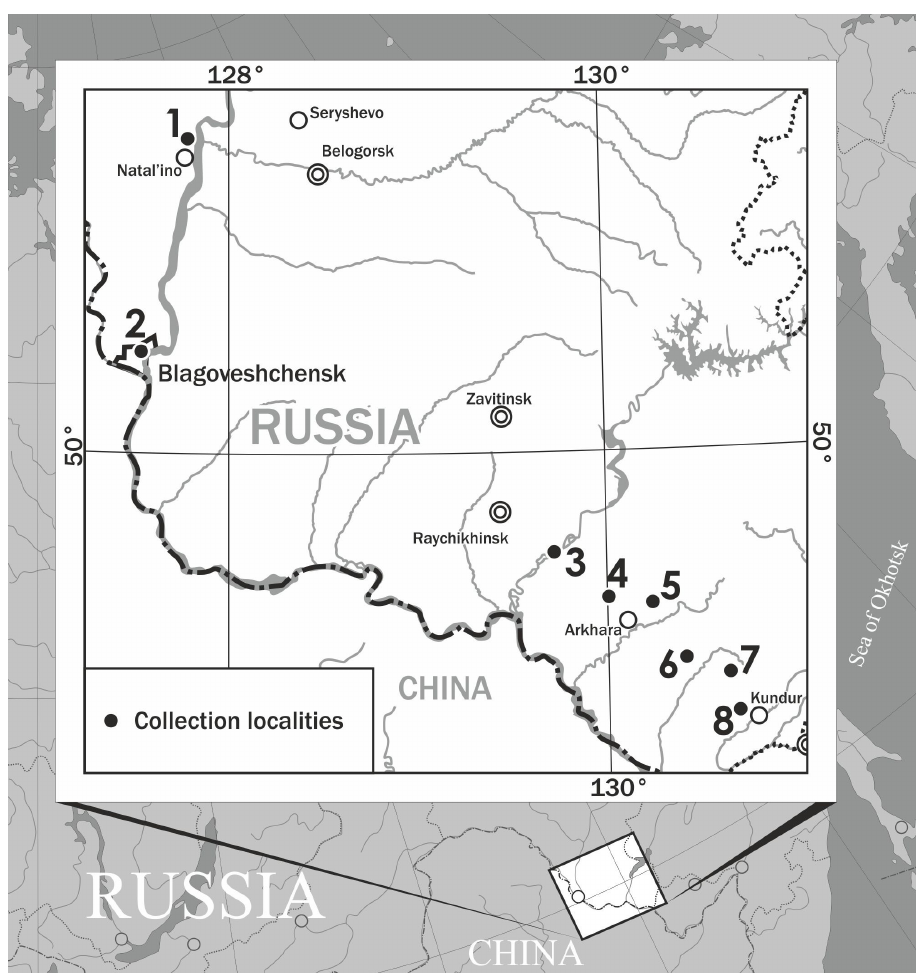
Figure 1. Map of the of collection localities. See the text for